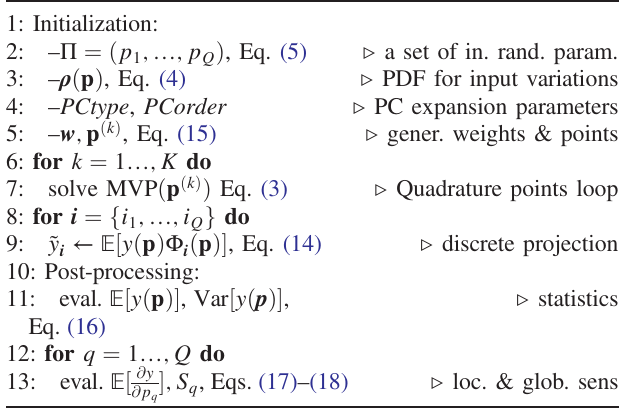
Algorithm 1. Pseudospectral approach for